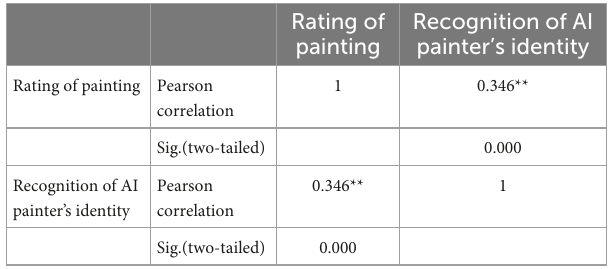
TABLE 4 Correlation analysis between rating of painting and recognition of AI painter’s